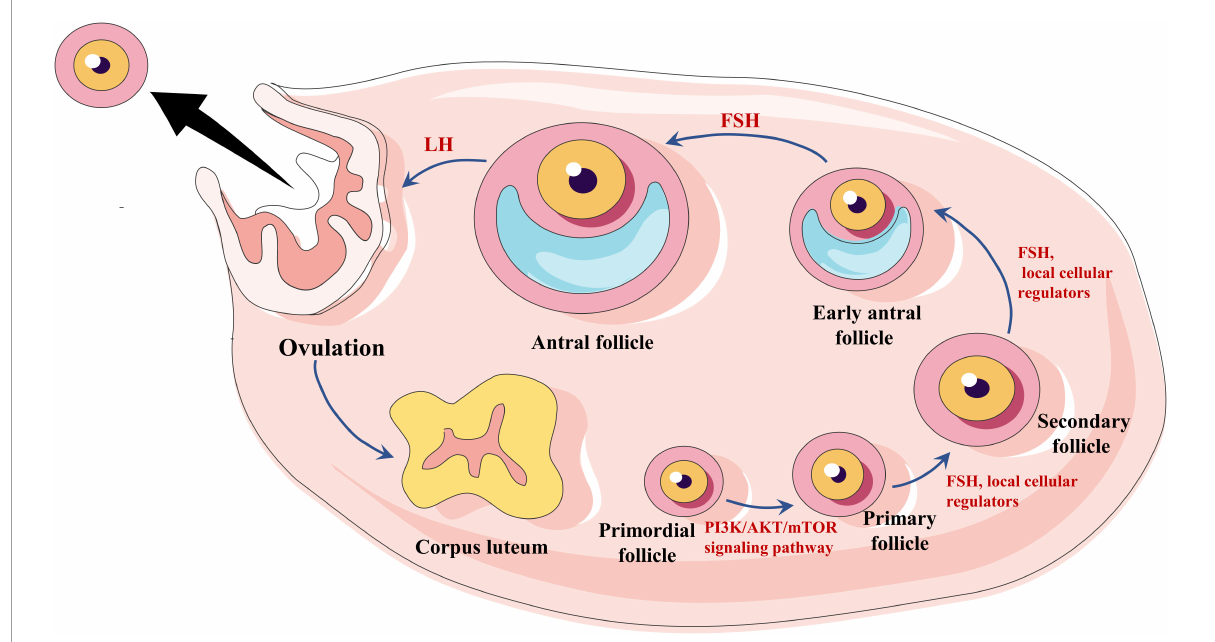
FIGURE1 Hormonal regulation of follicle growth and expulsion. Primordial follicles are regulated by the PI3K/AKT/mTOR signaling pathway to a primary stage of development, followed by the development of sinus follicles by the action of follicle-stimulating hormone (FSH) and local cellular regulators. Eventually, the oocyte matures under the influence of LH, and ovulation occurs.